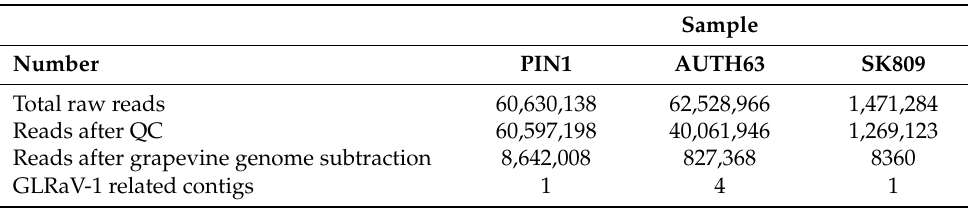
Table 1. HTS bioinformatic analysis of GLRaV-1 infected grapevines. Details of reads/contigs numbers at each analysis step are indicated.